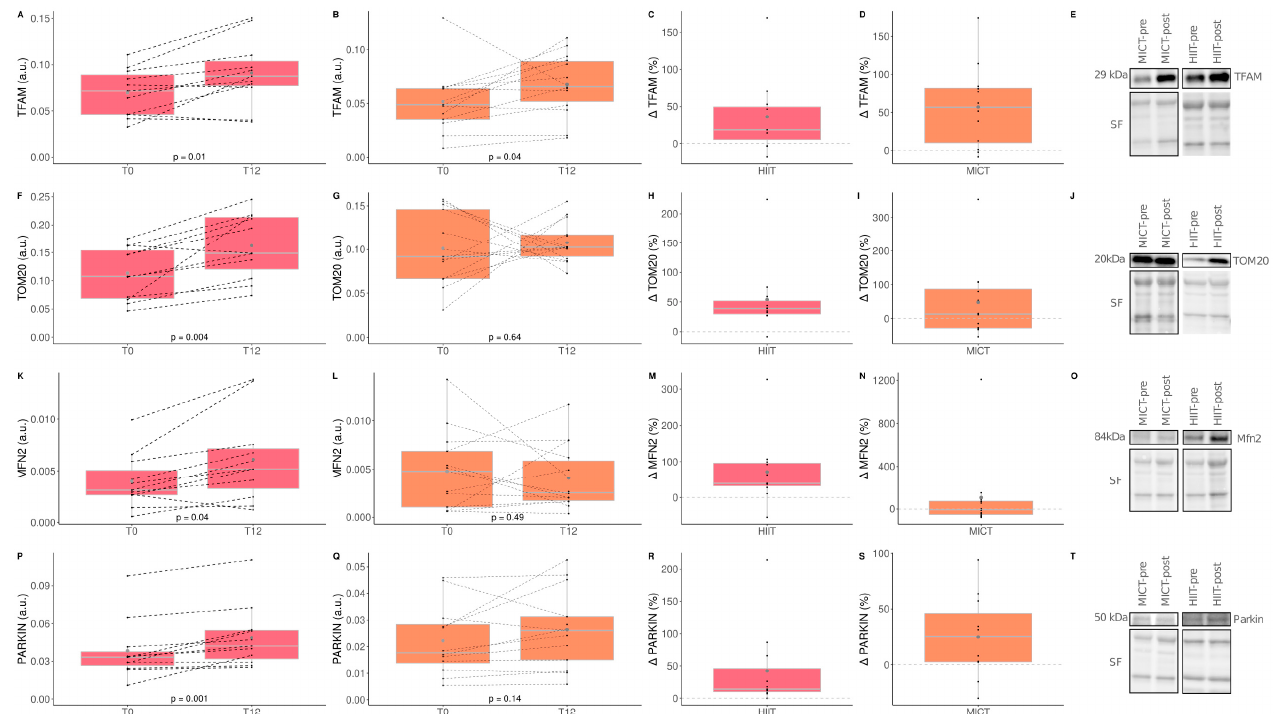
Figure 6. Impact of HIIT and MICT on markers of skeletal muscle mitochondrial content and quality control processes. HIIT = high-intensity interval training (pink), MICT = moderate-intensity continu- ous training (orange), T0 = before the 12-week intervention, T12 = after the 12-week intervention, delta change between T0 and T12 is expressed in %. TFAM = mitochondrial transcription factor A; TOM20 = translocase of outer membrane 20; MFN2 = Mitofusin-2; PARKIN = Parkin RBR E3 ubiquitin protein ligase. TFAM content in HIIT ( A ), TFAM content in MICT ( B ), delta change of TFAM content in HIIT ( C ), delta change of TFAM content in MICT ( D ), representative TFAM western blot and its corresponding stain free (loading control) for HIIT and MICT pre and post intervention ( E ), TOM20 content in HIIT ( F ), TOM20 content in MICT ( G ), delta change of TOM20 content in HIIT ( H ), delta change of TOM20 content in MICT ( I ), representative TOM20 western blot and its corresponding stain free (loading control) for HIIT and MICT pre and post intervention ( J ), MFN2 content in HIIT ( K ), MFN2 content in MICT ( L ), delta change of MFN2 content in HIIT ( M ), delta change of MFN2 content in MICT ( N ), representative MFN2 western blot and its corresponding stain free (loading control) for HIIT and MICT pre and post intervention ( O ), PARKIN content in HIIT ( P ), PARKIN content in MICT ( Q ), delta change of PARKIN content in HIIT ( R ), delta change of PARKIN content in MICT ( S ), representative PARKIN western blot and its corresponding stain free (loading control) for HIIT and MICT pre and post intervention ( T ). Each black dot represents a subject (the dashed line connects the T0 and T12 values of each subject), the grey point the mean, and the grey line in the boxplot the